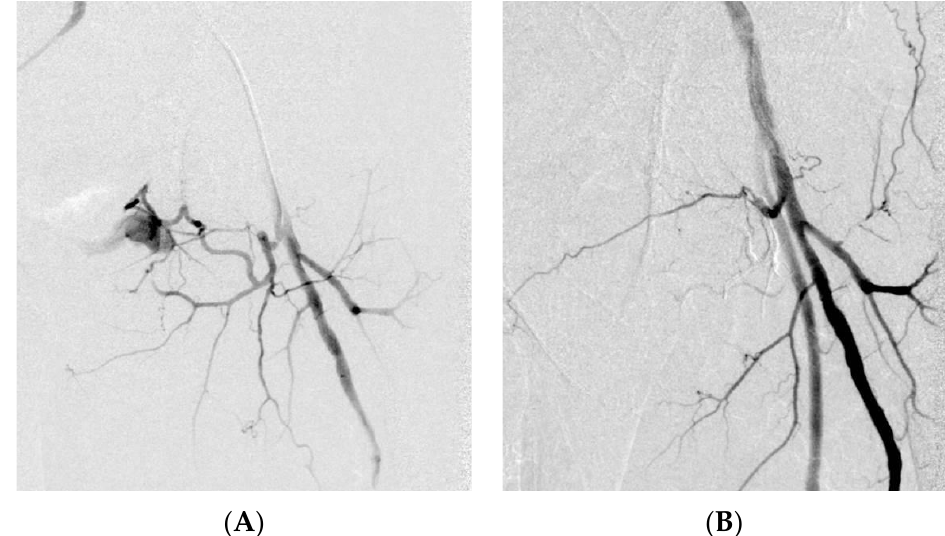
Figure 2. Road traffic collision. Selective digital subtraction angiography showing injury of an ascending branch of the medial circumflex artery with pseudoaneurysm formation ( A ). Digital subtraction angiography demonstrates the filling properties of the EVOH copolymer, resulting in effective embolization ( B ).